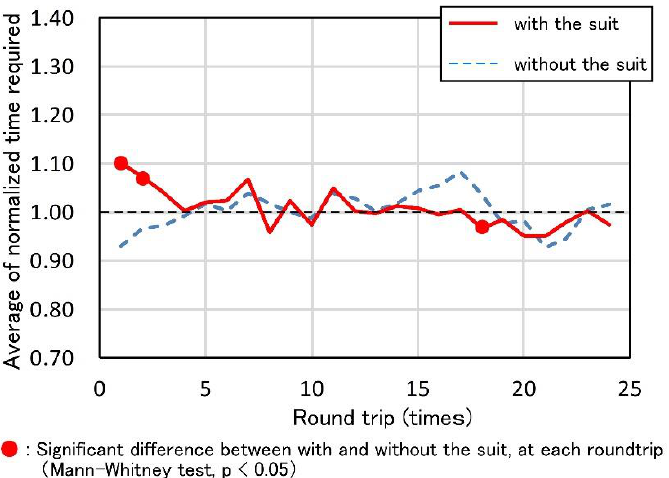
Figure 7. Change in the average of normalized time (TNi) for participants of the power assist suit